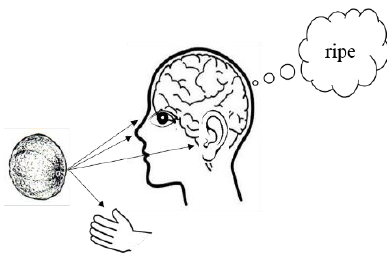
Figure 1. The senses involved in deciding whether a cantaloupe is ripe.